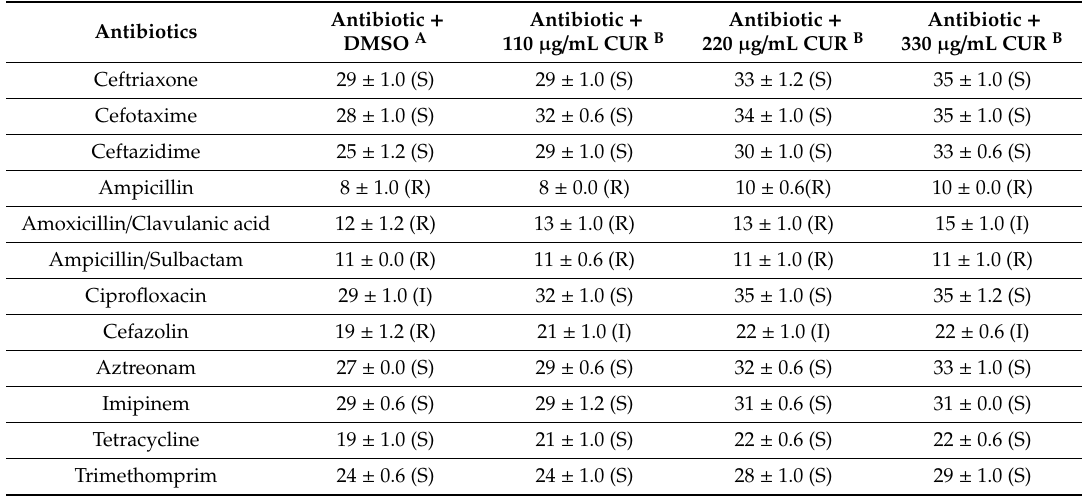
Table 3. Zone of inhibition (mm) and susceptibility of different antibiotics against a strain of Enterotoxigenic Escherichia coli in the absence and presence of curcumin.